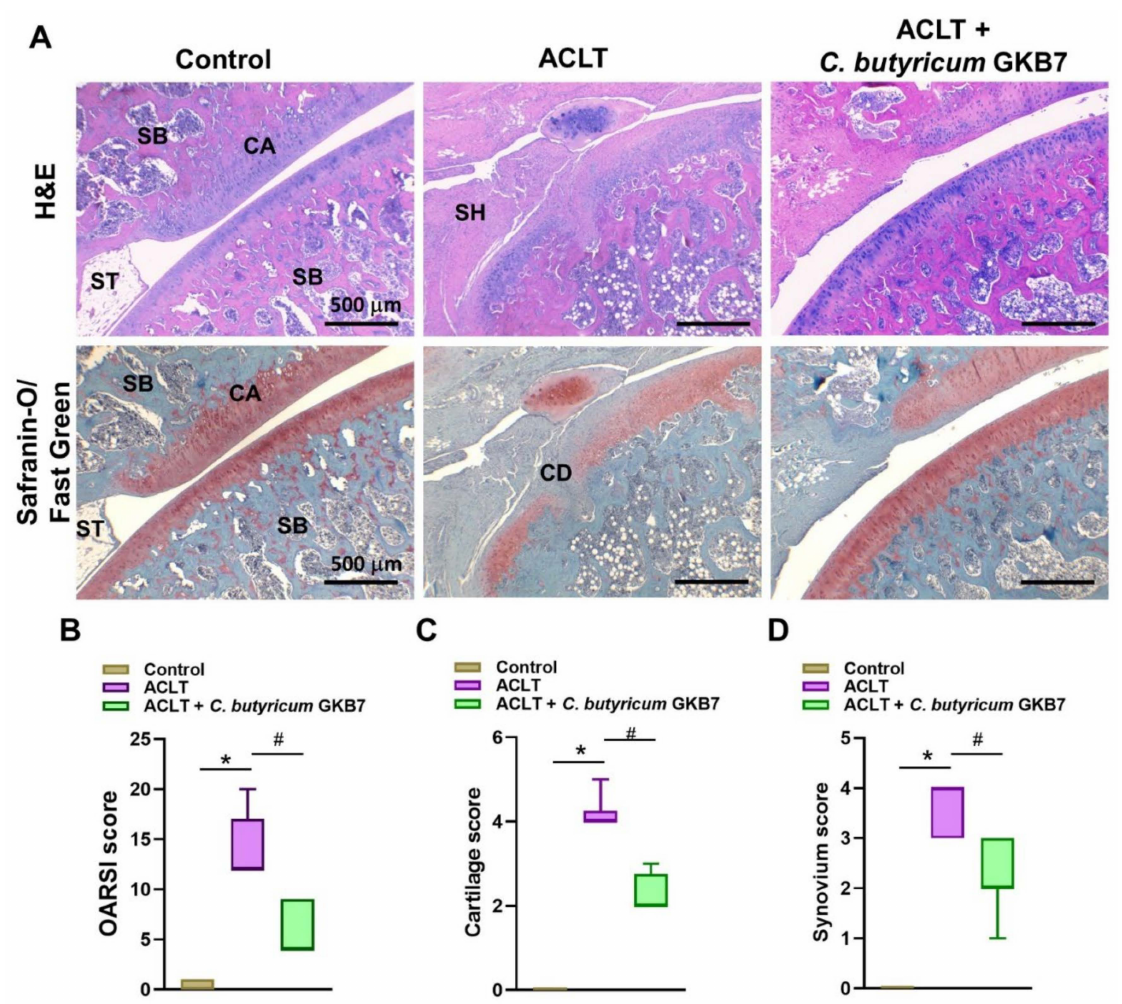
Figure 4. Oral C. butyricum GKB7 ameliorates articular cartilage damage. ( A ) Histopathological analysis of right knee articular cartilage specimens stained with H&E and Safranin-O/Fast Green. Less severe cartilage damage (CD) was observed in the ACLT + C. butyricum GKB7 group compared with the ACLT-only group. ( B – D ) Assessment of osteoarthritic cartilage histopathology by OARSI total scores ( B ), cartilage degeneration scores ( C ), and synovial membrane inflammation scores ( D ). Abbreviations: ST, synovial tissue; CA, cartilage; SB, subchondral bone; SH, synovial hyperplasia. * p < 0.05 ACLT-only vs. controls; # p < 0.05 ACLT-only vs. ACLT + C. butyricum